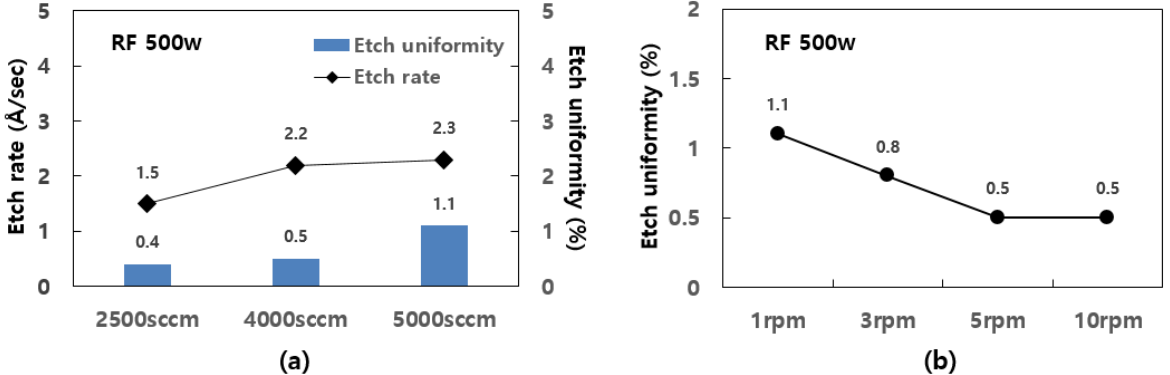
Figure 4. ( a ) Trend of etch rate and etch uniformity according to NF 3 flow rate. ( b ) Trend of etch uniformity with increasing wafer rpm.